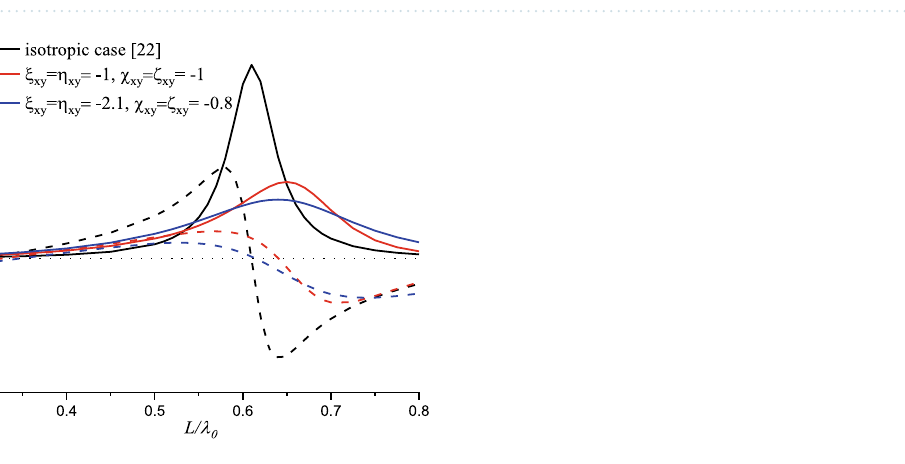
Figure 25. Input impedance for combined reciprocal chiral and Tellegen